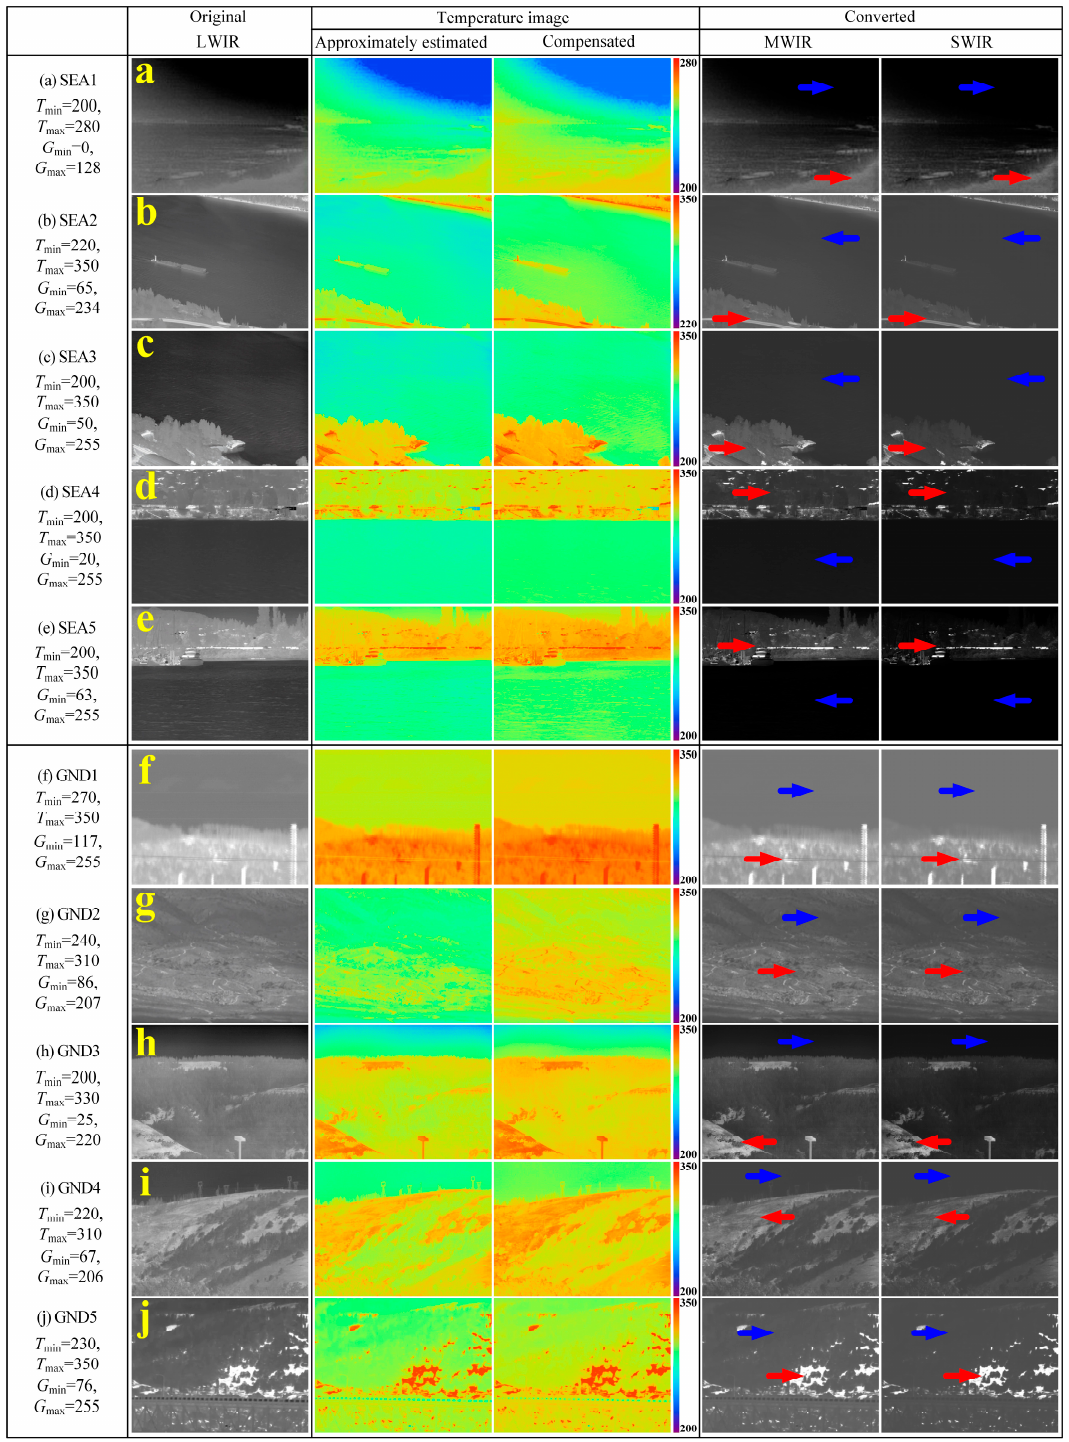
Figure 11. MWIR and SWIR conversion results using the proposed method of various sea and ground background images, ( a – e ) SEA1~SEA5 and ( f – j ) GND1~GND5.